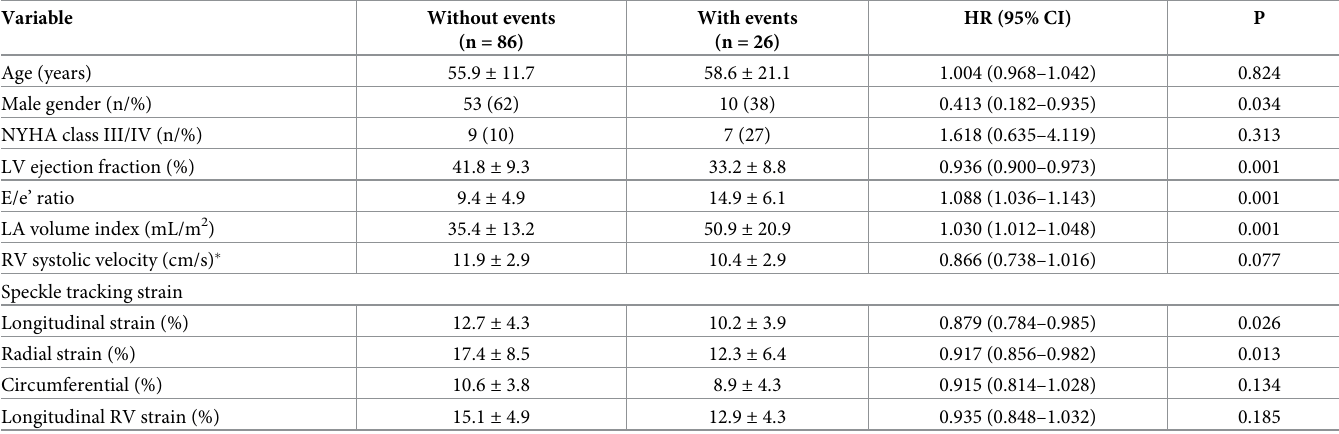
Table 3. Predictors of adverse cardiac events in patients with dilated cardiomyopathy: Univariate analysis. Variable